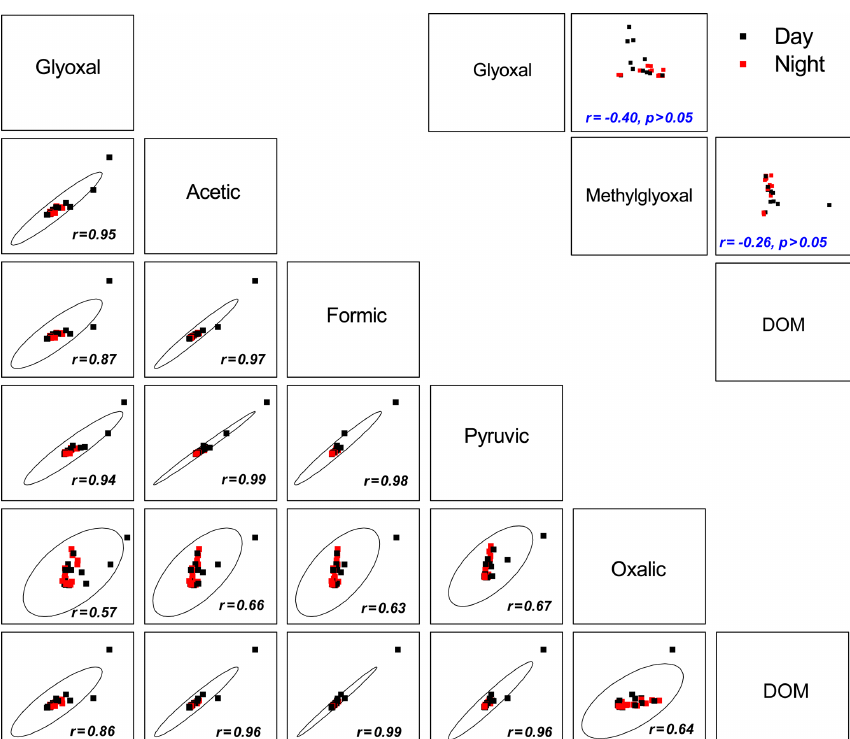
Figure 6. Pairwise scatter plot of selected organic species in cloud water. The confidence ellipses were plotted (using OriginPro 2015 software) to indicate the strength of bivariate correlations at a 99% confidence level. The confidence ellipse collapses diagonally as the correlation between two variables approaches 1 or − 1, and it becomes more circular when two variables are